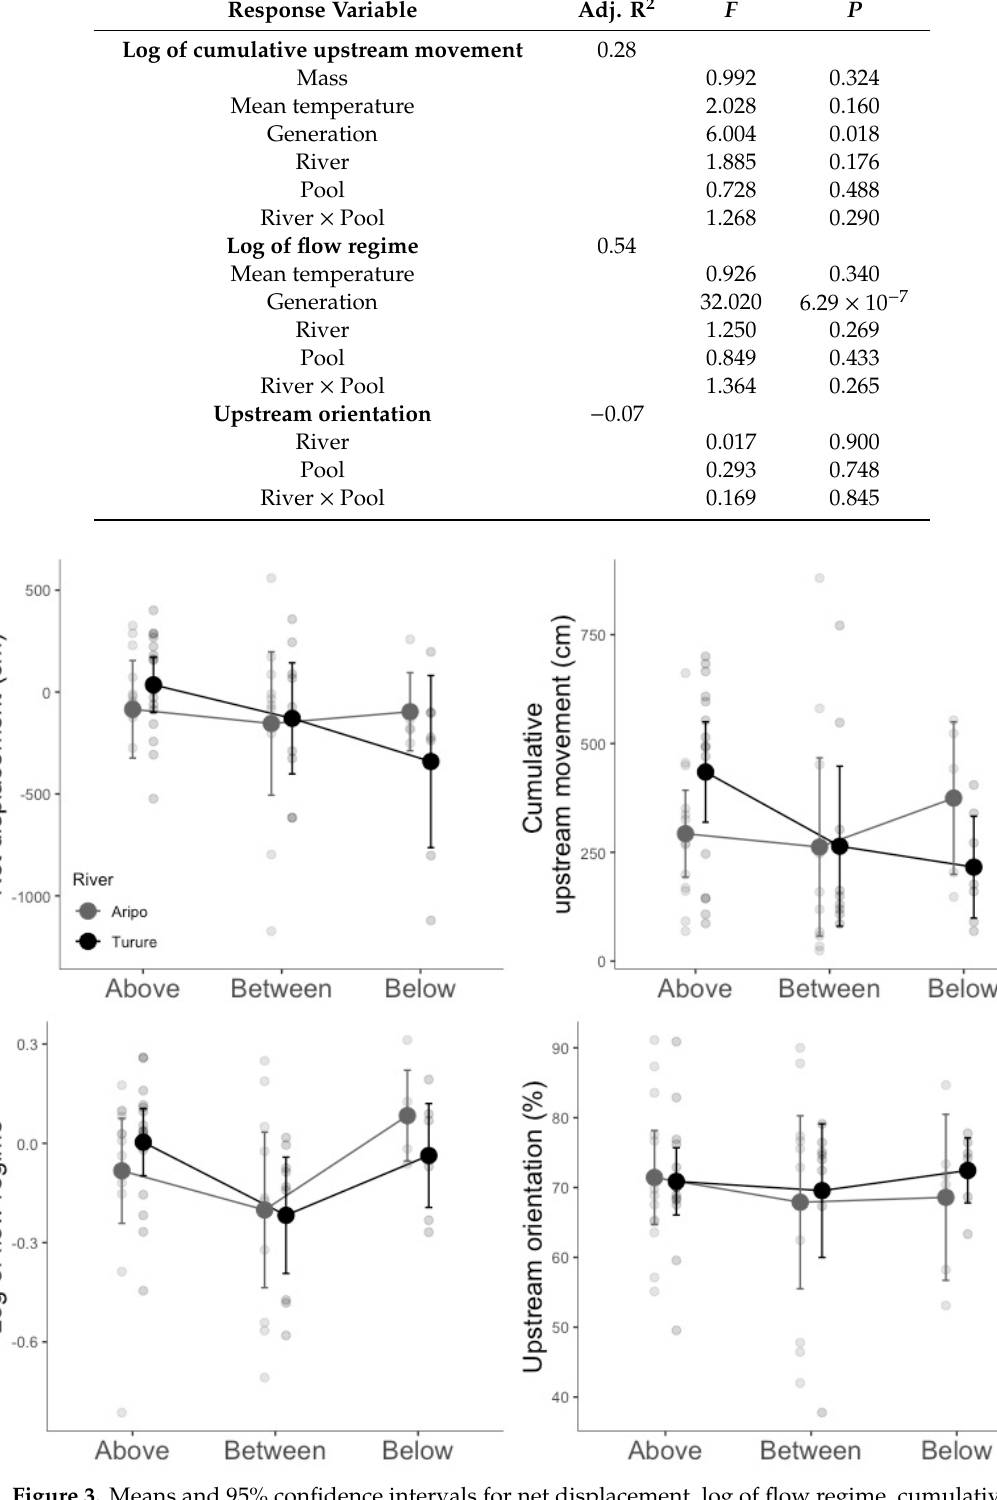
Figure 3. Means and 95% confidence intervals for net displacement, log of flow regime, cumulative upstream movement and upstream orientation, for each pool type in each river. The raw data points are presented in grey.